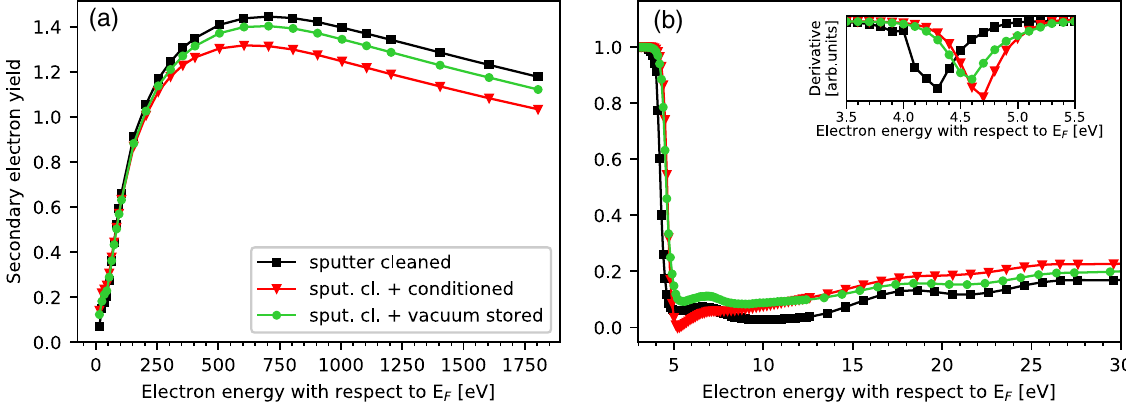
FIG. 5. (a) SEY curves from 10 to 1800 eVof a sputter-cleaned sample, before and after conditioning, and of a sputter-cleaned sample stored under vacuum, (b) low energy SEY curves, inset: derivative of the SEY curves in the vacuum level